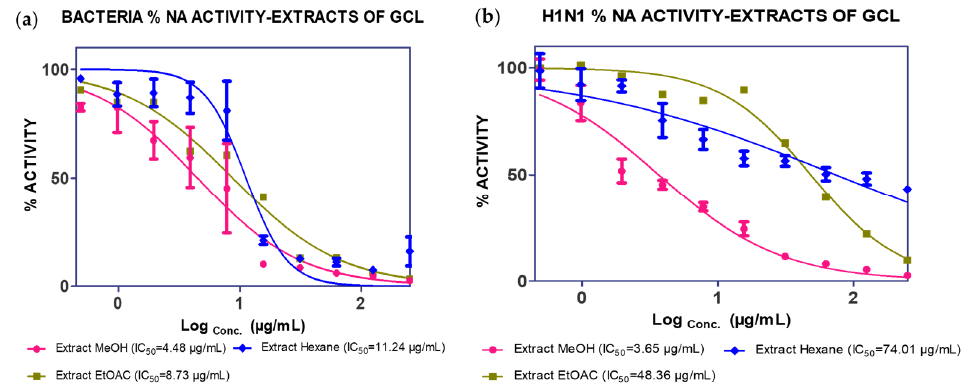
Figure 1. Neuraminidase enzyme (NA) inhibition activity of Garcinia celebica leaves (GCL) extracts against ( a ) C. perfringens -NA and ( b ) H 1 N 1 -NA.